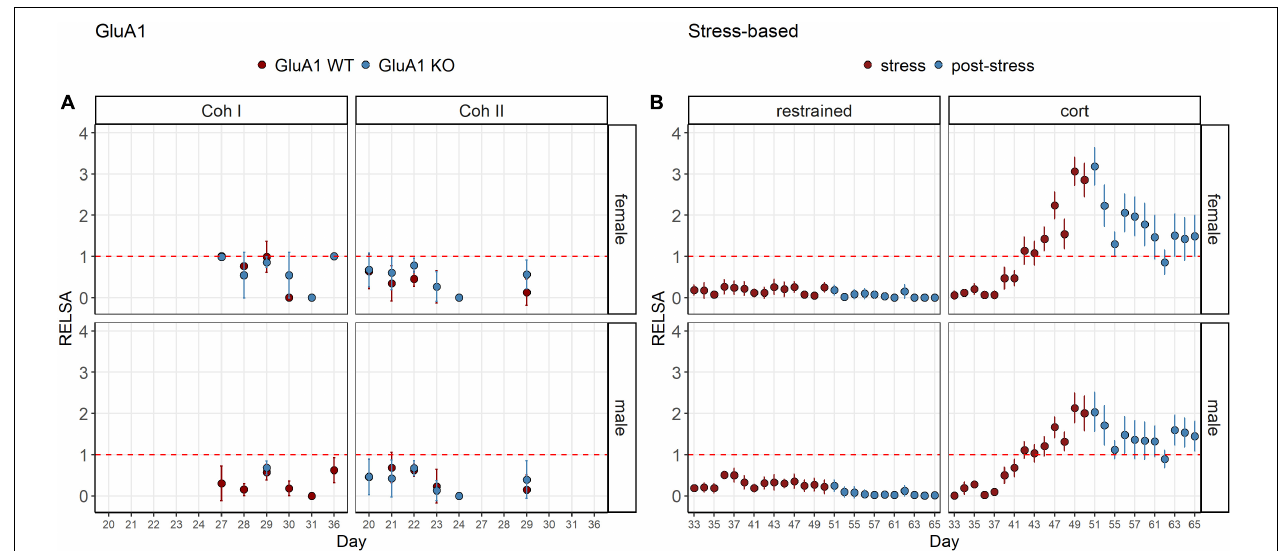
FIGURE 4 | RELSA flow : comparison of all models in the RELSA in the course of the experiment. (A) The RELSA shows fluctuations throughout the assessment in both cohorts and sexes. (B) In the stress-based models, the increase of the RELSA during the stress phase is evident in the corticosterone group. In the post-stress phase, the values drop, but do not reach the initial level. Restraint treatment only evokes a minor effect in males on day 36, but females display no burden according to the RELSA. Restraint stress serves as reference. The RELSA includes body weight, burrowing performance and fecal corticosterone metabolite concentrations. The red line indicates the reference maximum. Data was analyzed using RELSA in R, GluA1 KO stress-based experiment, except corticosterone n = 8, error bars are mean ± 95% ♀